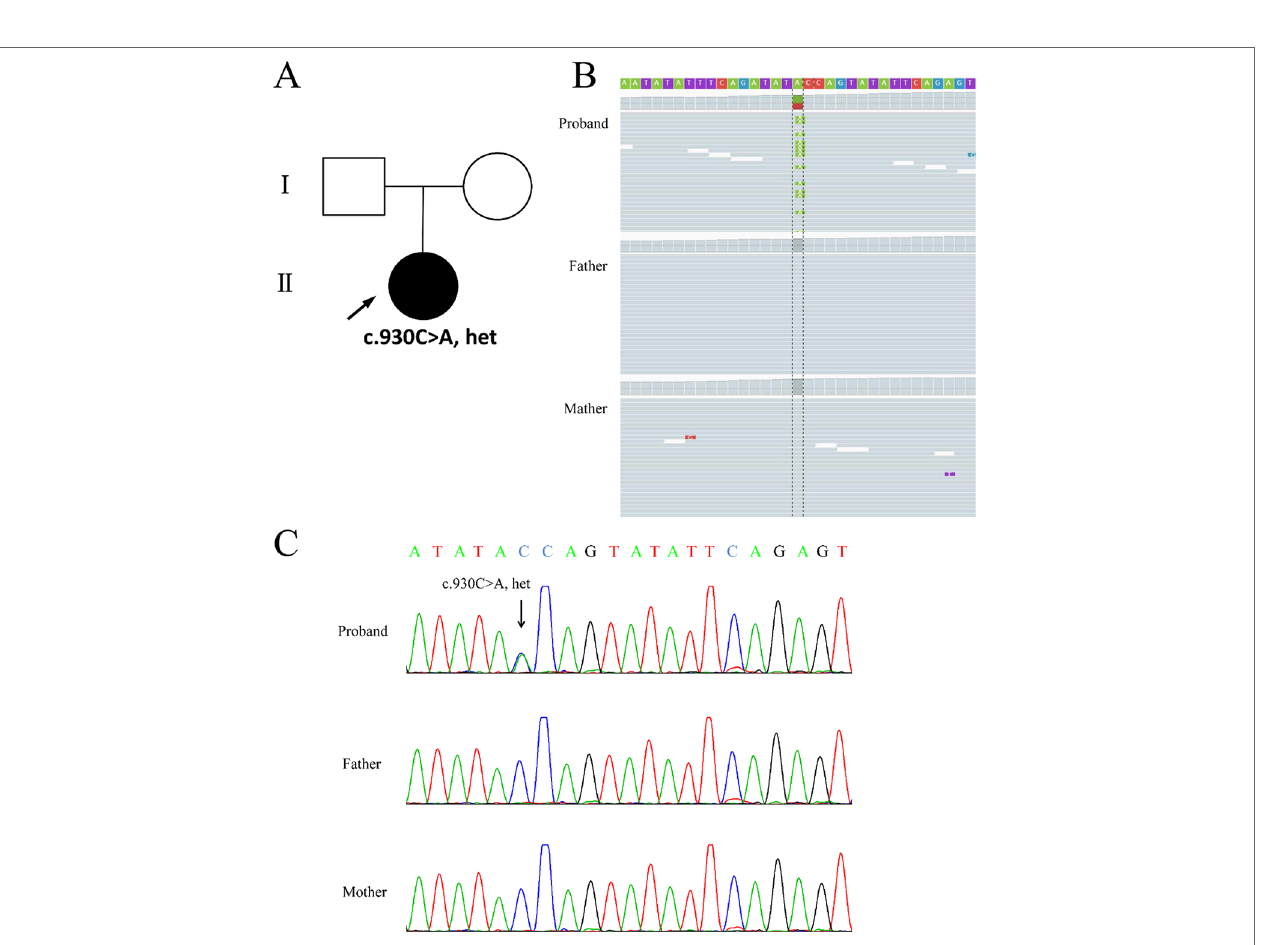
Frontiers in Genetics |